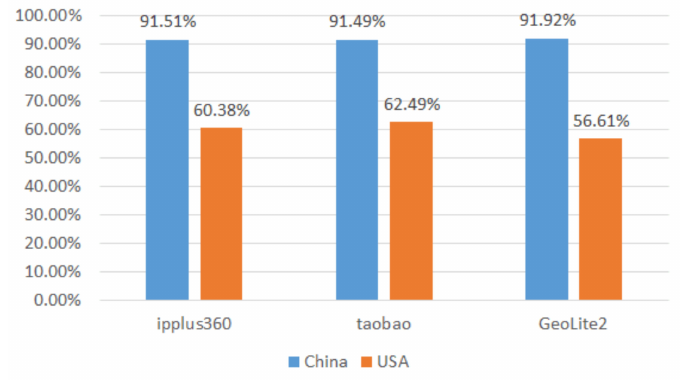
Figure 8. Proportion of overseas server dependency domain (POSD) of China and the